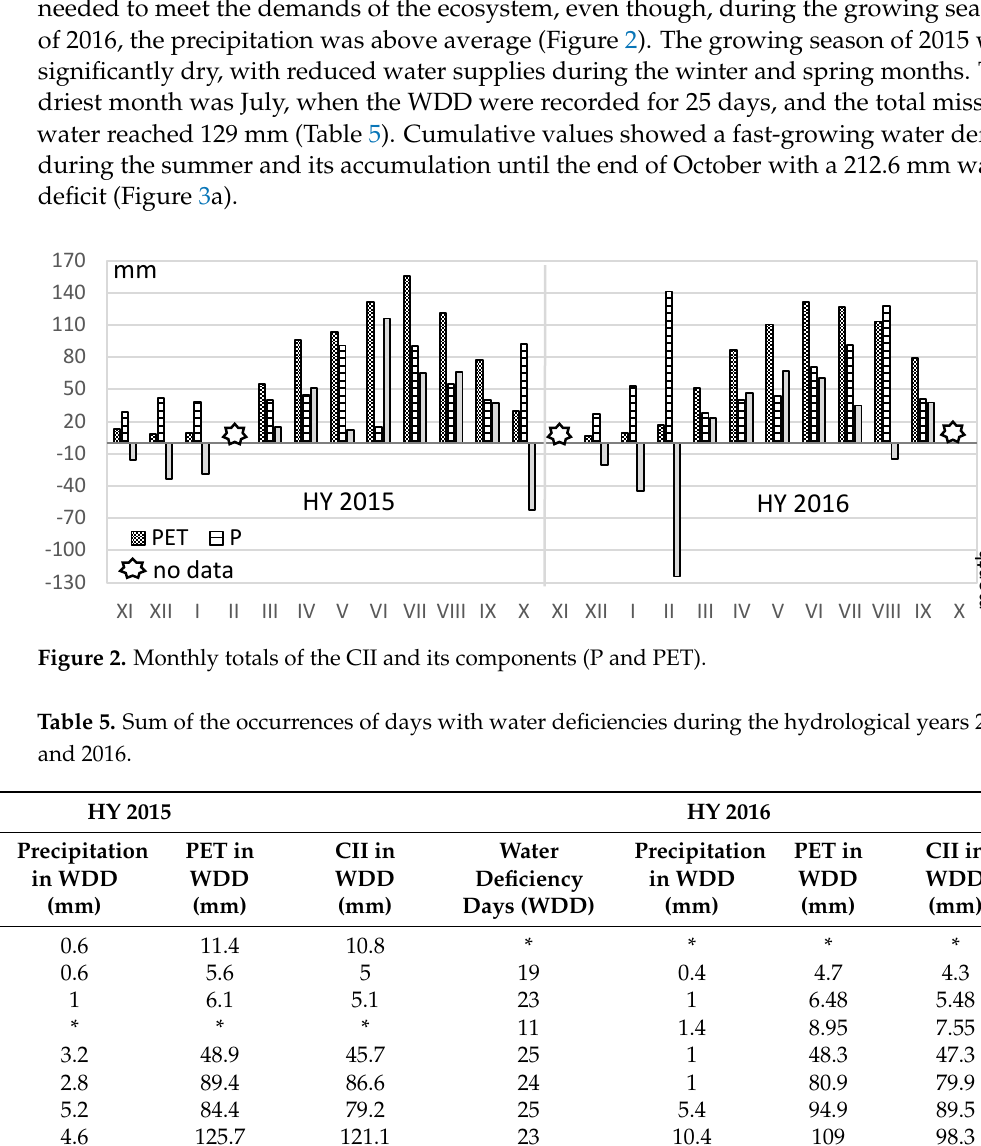
Figure 3. Cumulative values of the water deficit (mm) according to the CII in HY 2015 ( a ) and in HY 2016 ( b ). Positive values represent water deficits, and negative values represent water surpluses. Table 5. Sum of the occurrences of days with water deficiencies during the hydrological years 2015 and 2016.